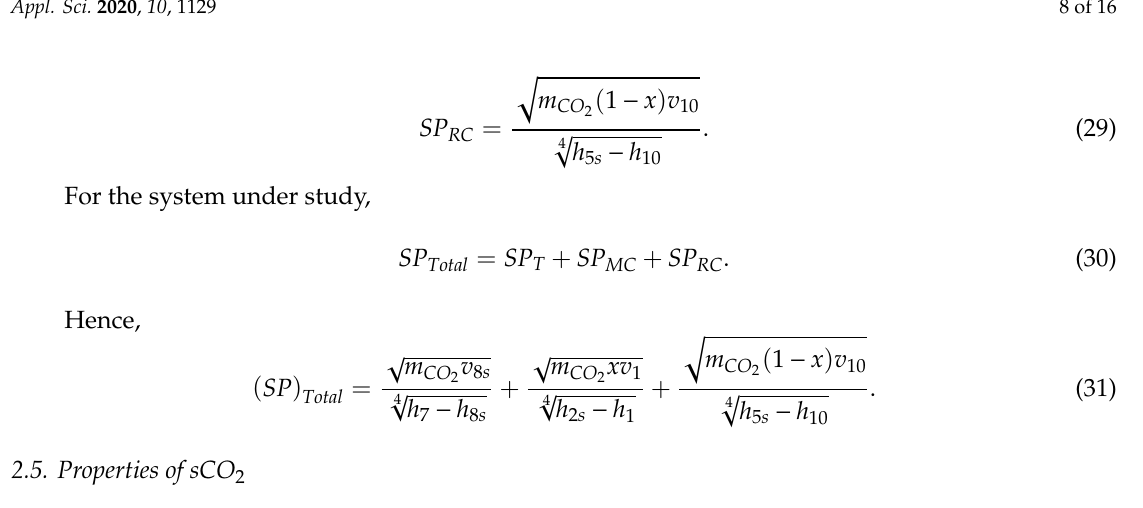
Table 2. Typical properties of CO 2 .